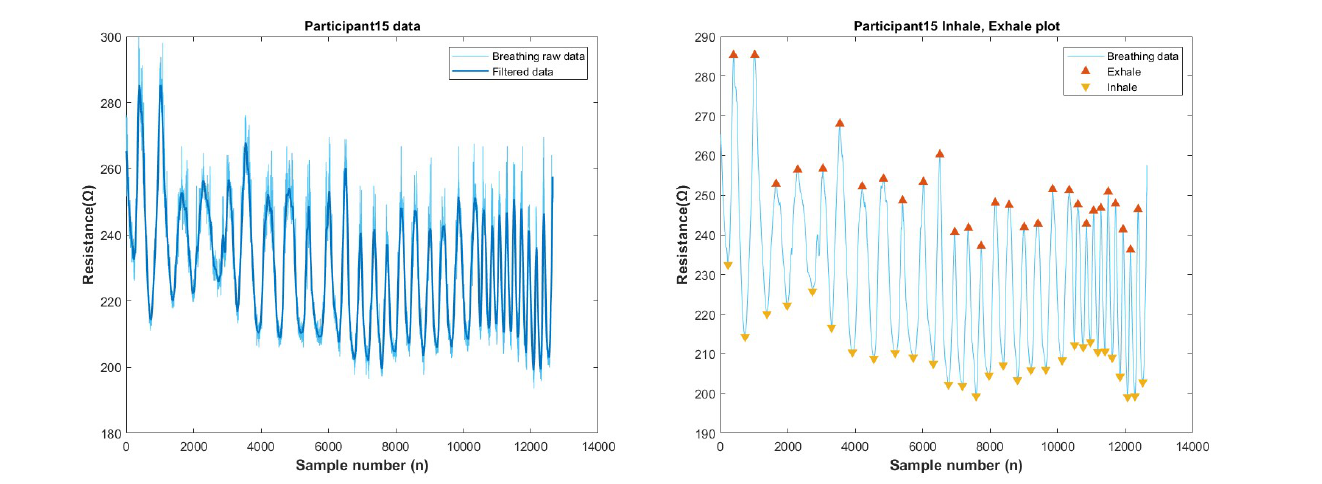
Figure A30. Breathing Test data of Participant